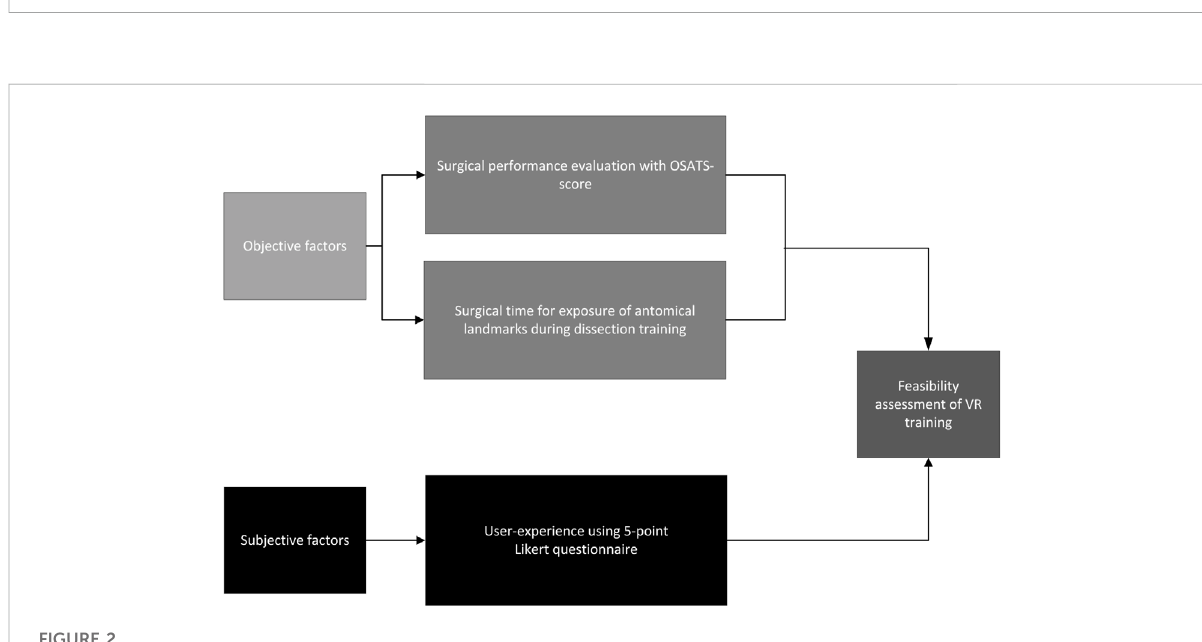
FIGURE 2 The factors and metrics used for feasibility assessment of VR